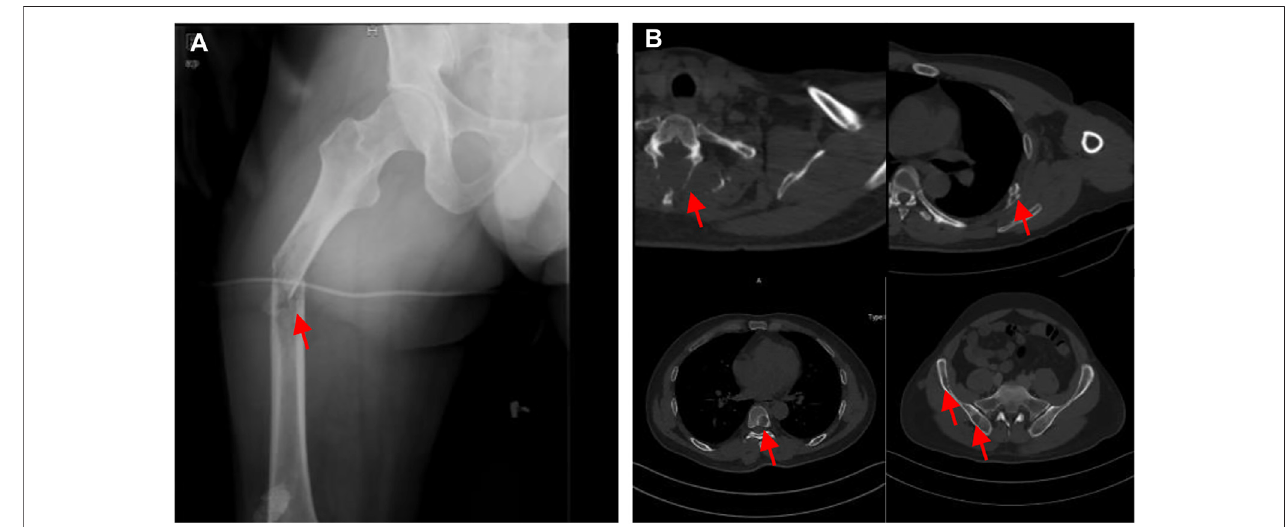
FIGURE 5 | (A) Pathological fracture of the right femur. (B) Metastases at the ribs, vertebral and ilium on